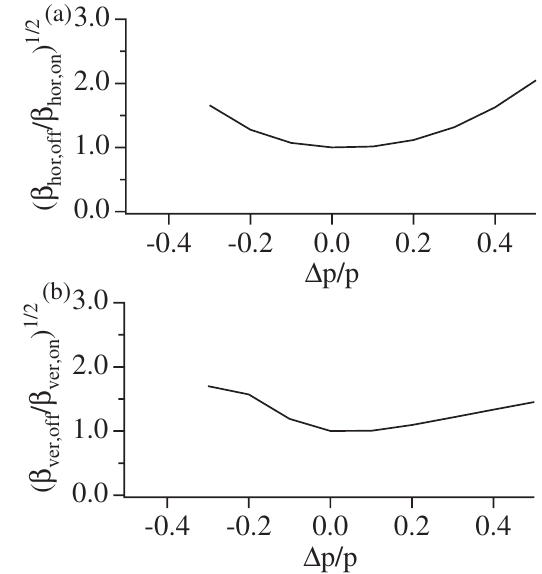
FIG. 12. (a) Horizontal and (b) vertical square root of beta functions of off-momentum beam normalized by that of the on- momentum one as a function of momentum